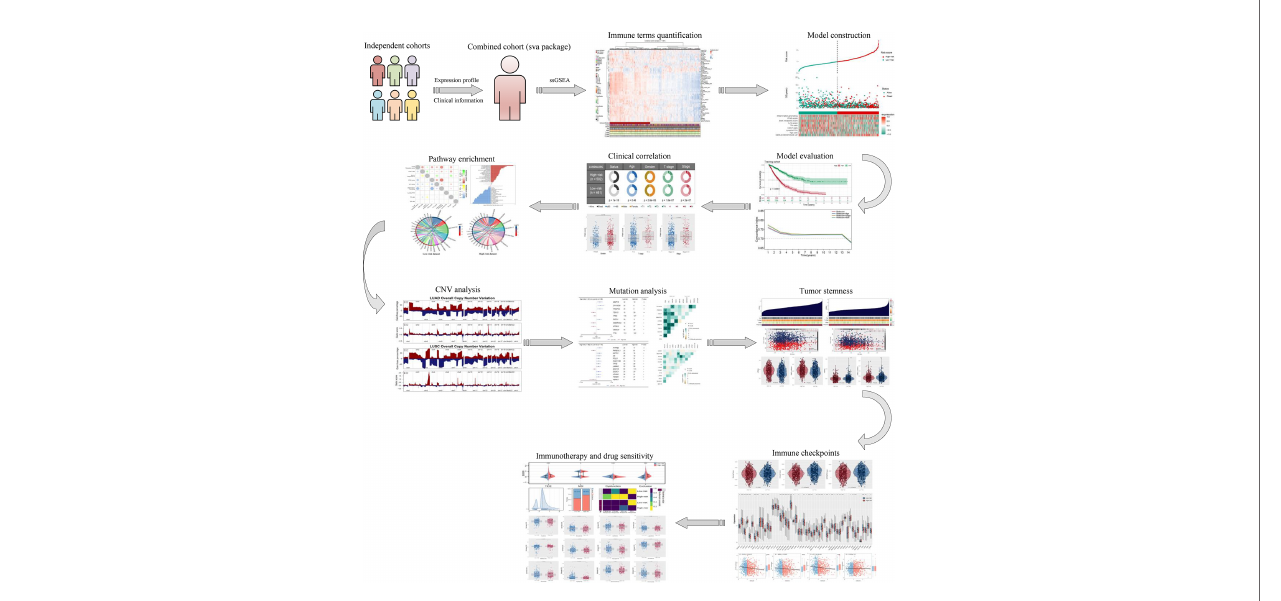
FIGURE 1 | The fl owchart of the whole study was shown in Figure 1